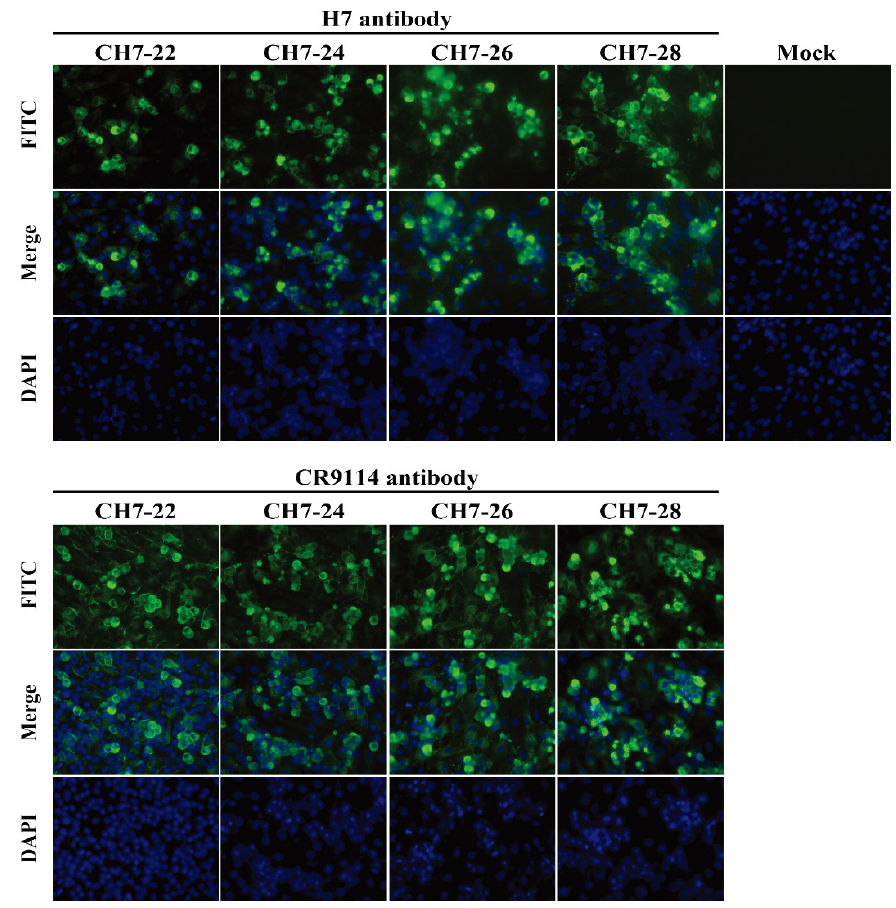
Figure 3. In vitro expression of consensus H7 HAs. BHK-21 cells (1 × 10 6 ) were transfected with 3 μg pCH7-22, pCH7-24, pCH7-26, pCH7-28, and pVAX1 (empty vector) using Lipofectamine 3000 Transfection Reagent (Invitrogen). After incubation for 5 h, the medium was replaced with fresh medium containing 10% fetal bovine serum. At 24 h post-transfection, the cells were washed with PBS, fixed with 4% paraformaldehyde (pH 7.4) for 30 min, permeabilized with 0.2% Triton X-100 in PBS for 30 min, and then stained with Hoechst 33258 for 30 min. Indirect immunofluorescence staining was performed with monoclonal antibodies CR9114 (broad-spectrum anti-stem neutralizing antibody) or P52E03 (targeting the HA head of subtype H7) and then FITC-labeled goat anti-human IgG. Imaging was conducted under a fluorescence microscope (Nikon Eclipse TE2000).